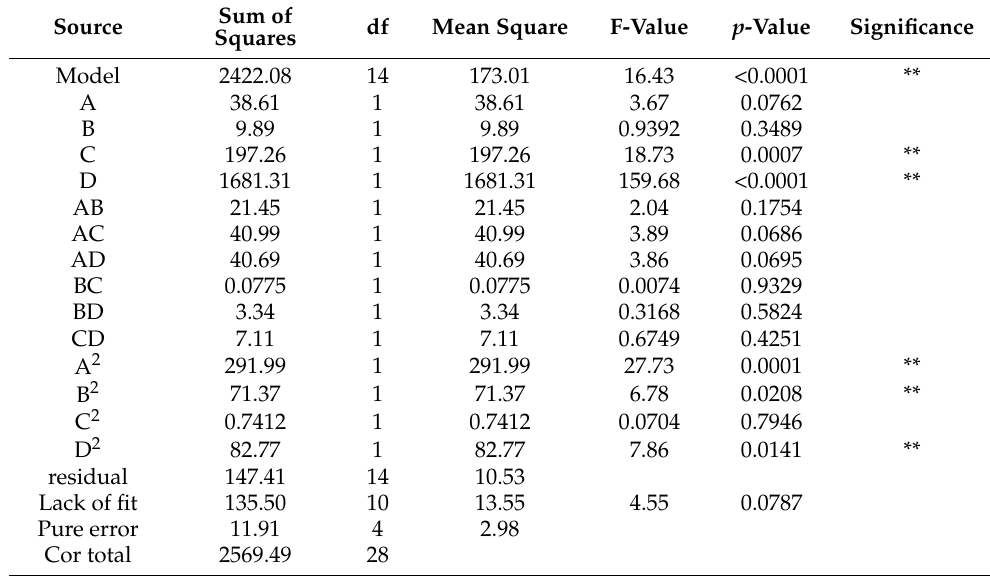
Table 2. Analysis of variance for each term in the fitted regression model. Sum of Source